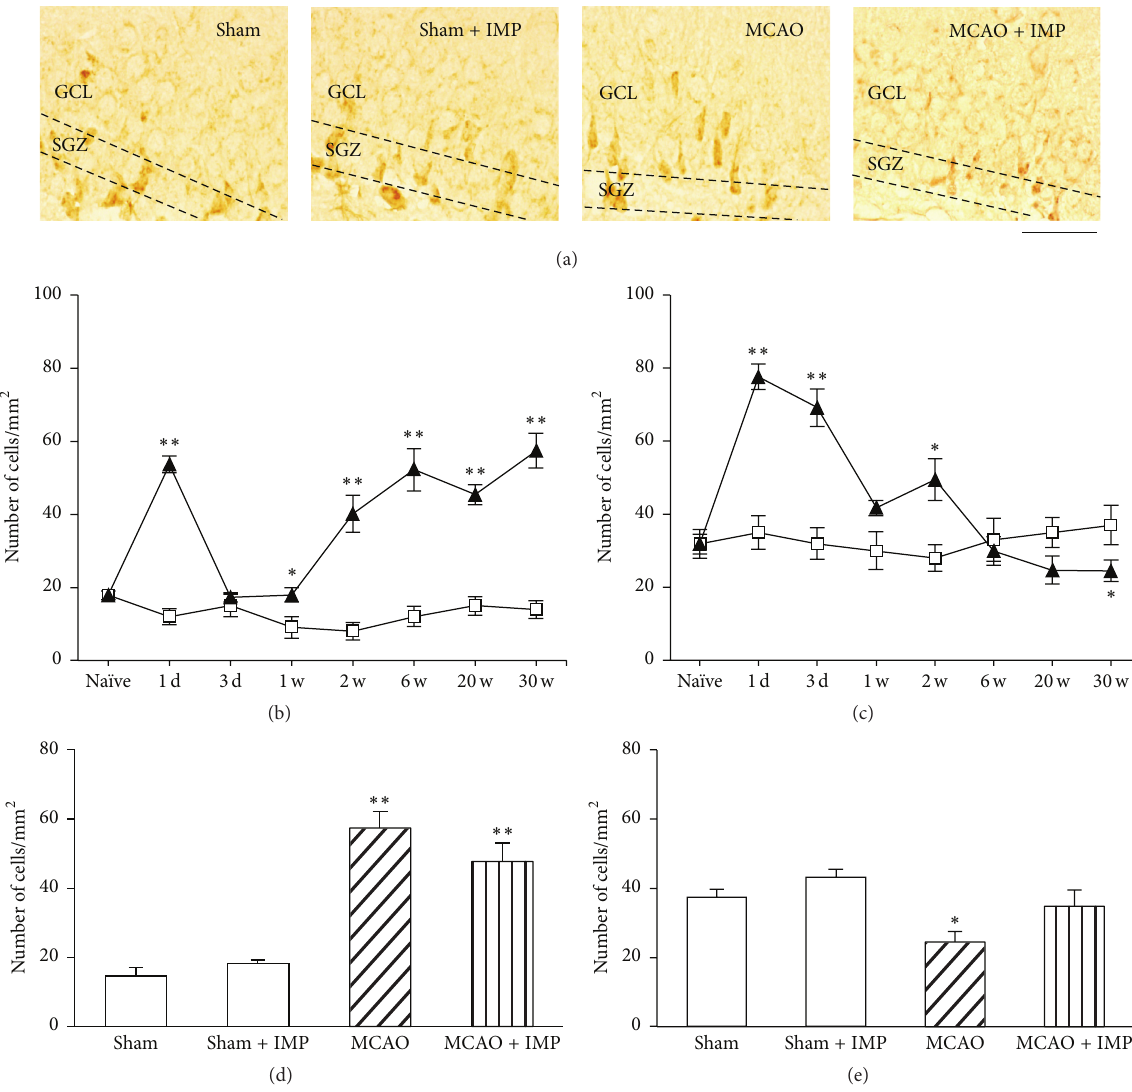
Figure 8: Analysis of the number of Bax immunopositive cells in the ipsilateral GCL and SGZ. (a) Typical images of the slices taken at 30 weeks after MCAO. Scale bar indicates 50 𝜇 m. (b, c) Time course changes of Bax immunopositive cells after MCAO in GCL (b) and SGZ (c). Symbols used are as follows: open square, sham; closed triangle, MCAO. Statistical significance was evaluated with two-way ANOVA followed = 18.1 , 𝐹 = 286.4 , 𝐹 = 19.3 , 𝑡 = 12.8 , 𝑡 = 2.46 , 𝑡 = 5.61 , by unpaired 𝑡 -test at each time point (GCL: 𝐹 ( ( group )1 ( time ∗ group )7,64 (1 d ) (1 w ) (2 w ) time )7 = 6.30 , 𝑡 = 11.3 , and 𝑡 = 7.95 ; SGZ: 𝐹 = 11.2 , 𝐹 = 27.8 , 𝐹 = 12.3 , 𝑡 = 7.51 , 𝑡 = 5.52 , 𝑡 = 3.17 , 𝑡 (6 w ) (20 w ) (30 w ) ( time )7 ( group )1 ( time ∗ group )7,64 (1 d ) (3 d ) (2 w ) = −2.00 ; ∗ 𝑃 < 0.05 and ∗∗ 𝑃 < 0.01 versus sham). (d, e) Analysis of the effect of IMP (20 mg/kg/day for 29 weeks) on the number and 𝑡 (30 w ) of Bax immunopositive cells at 30 weeks after MCAO in GCL (d) and SGZ (e). Statistical significance was evaluated with one-way ANOVA = 31.1 ; 𝐹 = 6.07 ; ∗ 𝑃 < 0.05 and ∗∗ 𝑃 < 0.01 versus sham [IMP( − )]; 𝑁 = 5 followed by Tukey-Kramer post hoc test ( 𝐹 ( ( SGZ )3,16 GCL )3,16